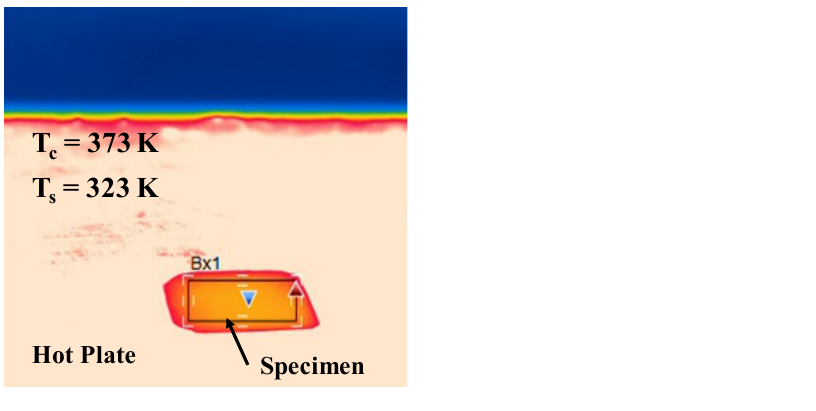
Figure 14. Comparison of the surface temperature between the bare copper and acicular micro-textured specimens, placed on the hot plate at 373 K.